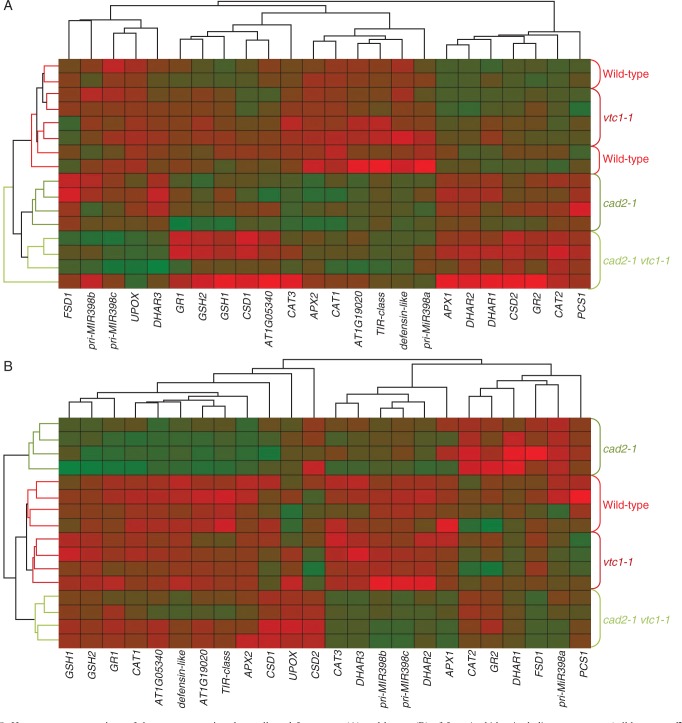
Heat map representations of the gene expression data collected from roots (A) and leaves (B) of four Arabidopsis thaliana genotypes (wild-type, cad2-1, vtc1-1 and cad2-1 vtc1-1) exposed to 5 μM CdSO4 for 72 h in hydroponics (n = 4). Hierarchical clustering of genes is shown on the top and bottom; genotype clustering is visualized on the left and right. Green shaded boxes indicate high, and red shaded boxes low gene expression. Genes: γ-glutamylcysteine synthetase (GSH1), glutathione synthetase (GSH2), phytochelatin synthase (PCS1), iron superoxide dismutase (FSD1), copper/zinc superoxide dismutase (CSD1-2), primary microRNA398 transcripts (pri-MIR398a-c), catalase (CAT1-3), ascorbate peroxidase (APX1-2), dehydroascorbate reductase (DHAR1-3), glutathione reductase (GR1-2), Toll-Interleukin-1 class (TIR), upregulated by oxidative stress (UPOX).